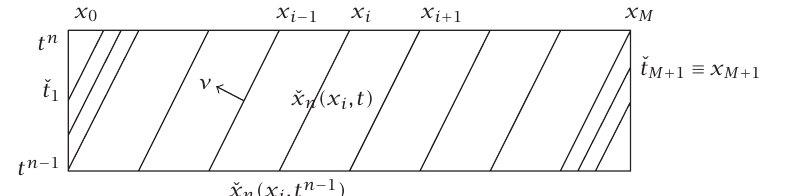
Figure 2.3 . An illustration of